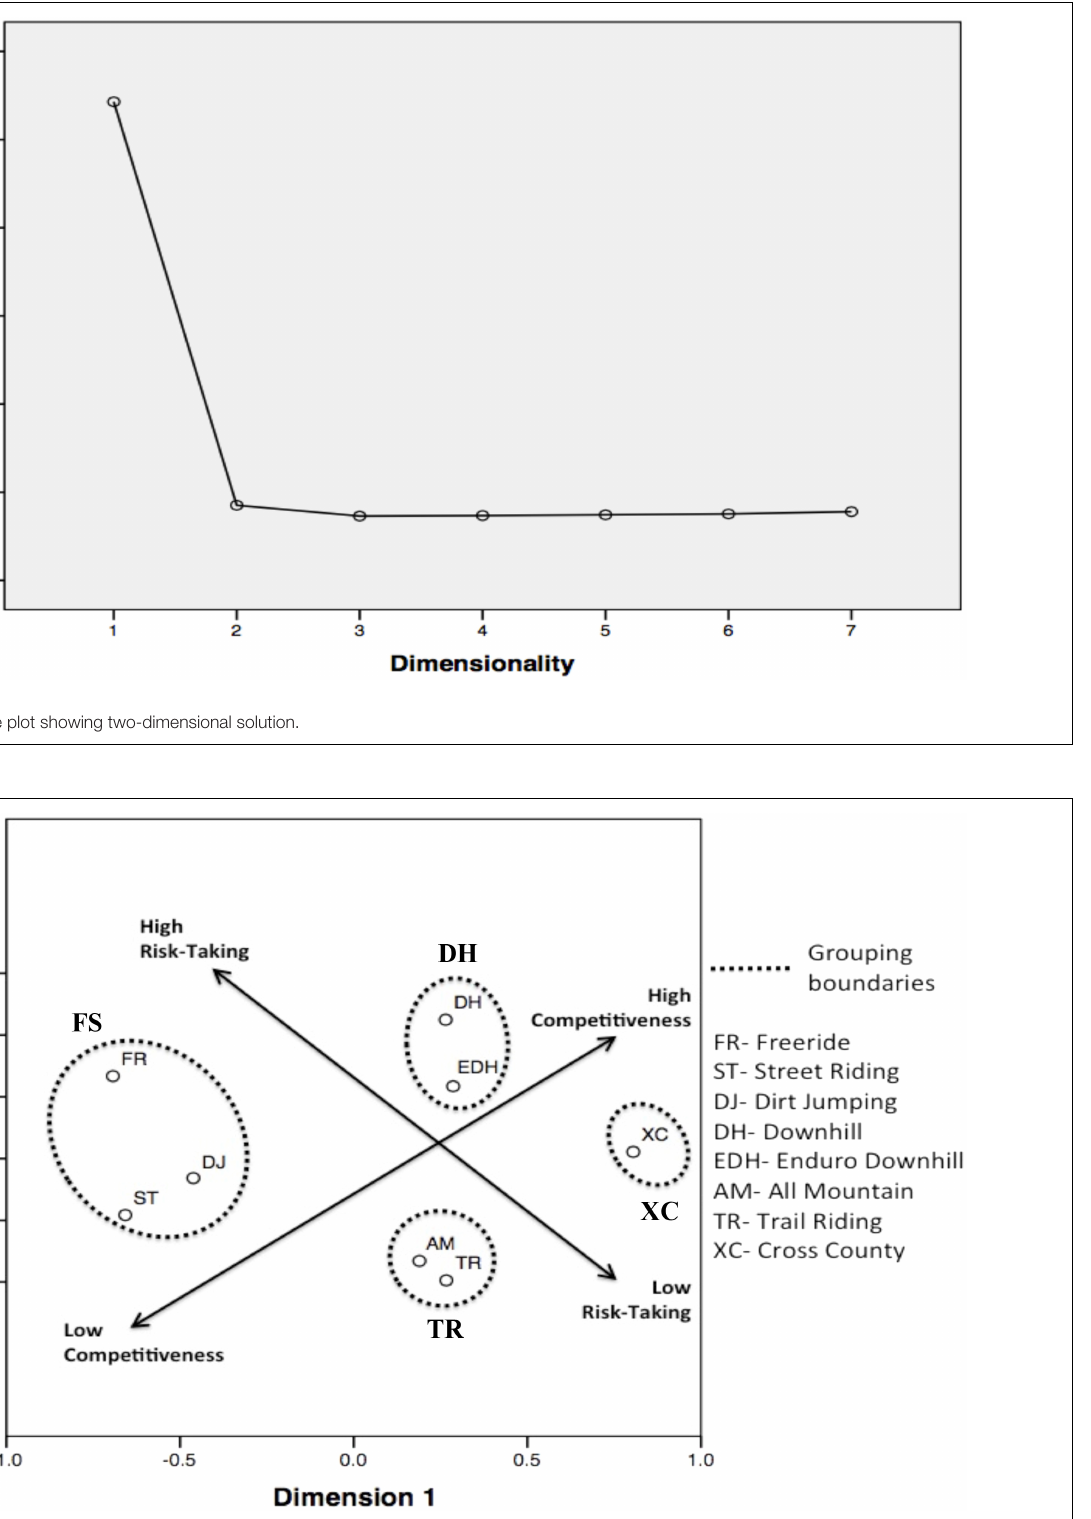
FIGURE 3 | Interpreted bi-dimensional MDS common space diagram showing the clustering of riding styles into the four groupings of Freestyle (FS), Downhill (DH), Cross Country (XC) and Trail Riding